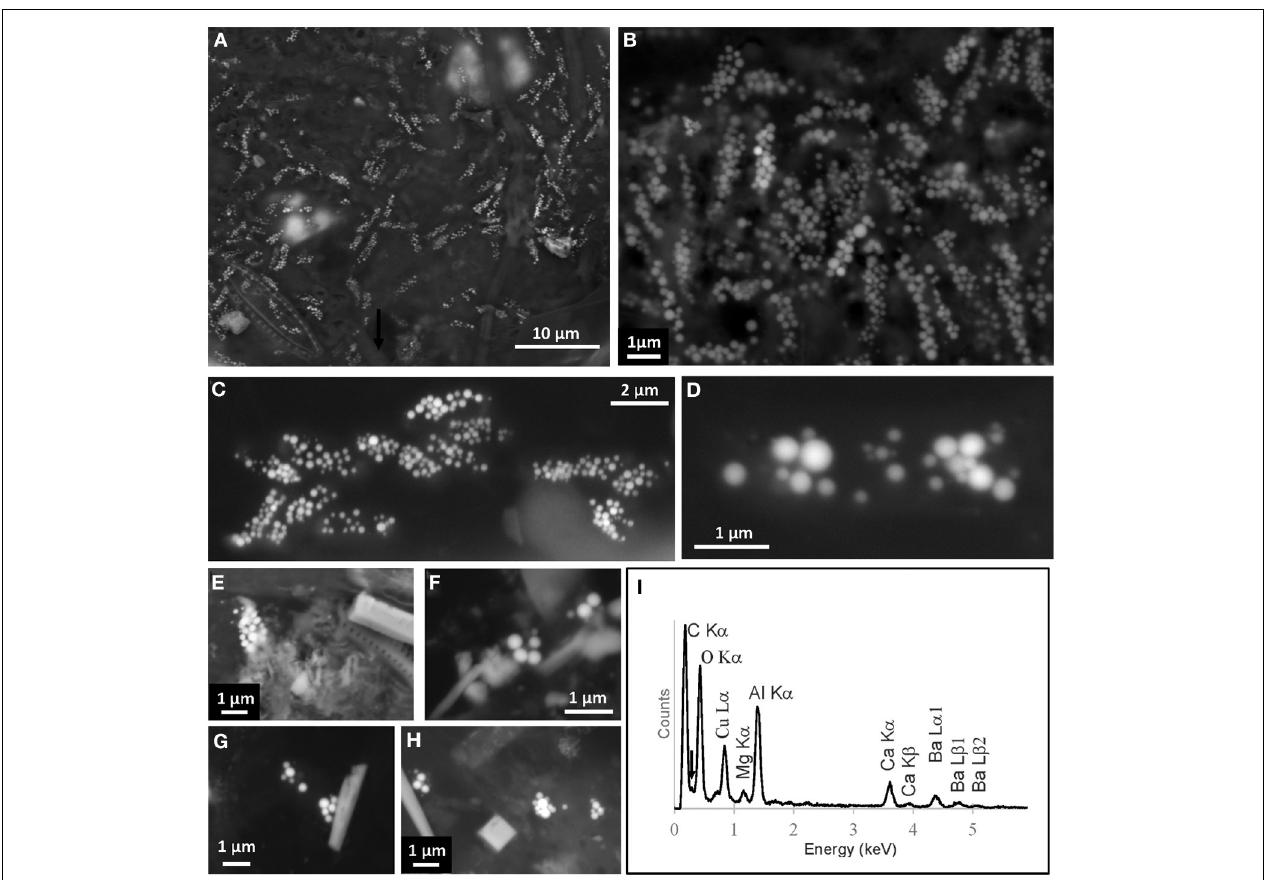
FIGURE 2 | Scanning electron microscopy images of cyanobacteria with intracellular carbonate inclusions in environmental samples. (A,B) Images of Gloeomargarita -like cells growing in the biofilm of aquarium AQ1 where G. lithophora was isolated from. (C) Gloeomargarita -like cells in a biofilm sample from aquarium AQ2. (D–H) Individual Gloeomargarita -like cells in natural thermophilic mat samples (Algerian hot spring St7, Meskoutine; Amarouche-Yala et